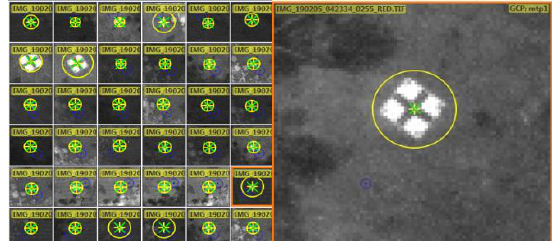
. Figure 6. GCP marking in rayCloud view